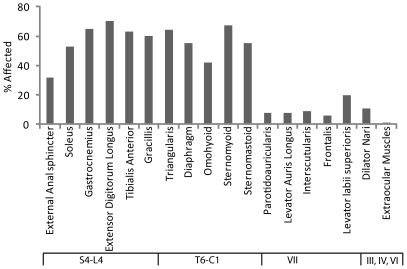
Relationship of rostrocaudal position and segmental innervation to the incidence of age-related alterations in NMJs.Muscles listed in Table 1 are arranged by the rostrocaudal position of the motor pool that innervates them. The ordinate is the percentage of NMJs with age-associated defects from column 6 of Table 1.